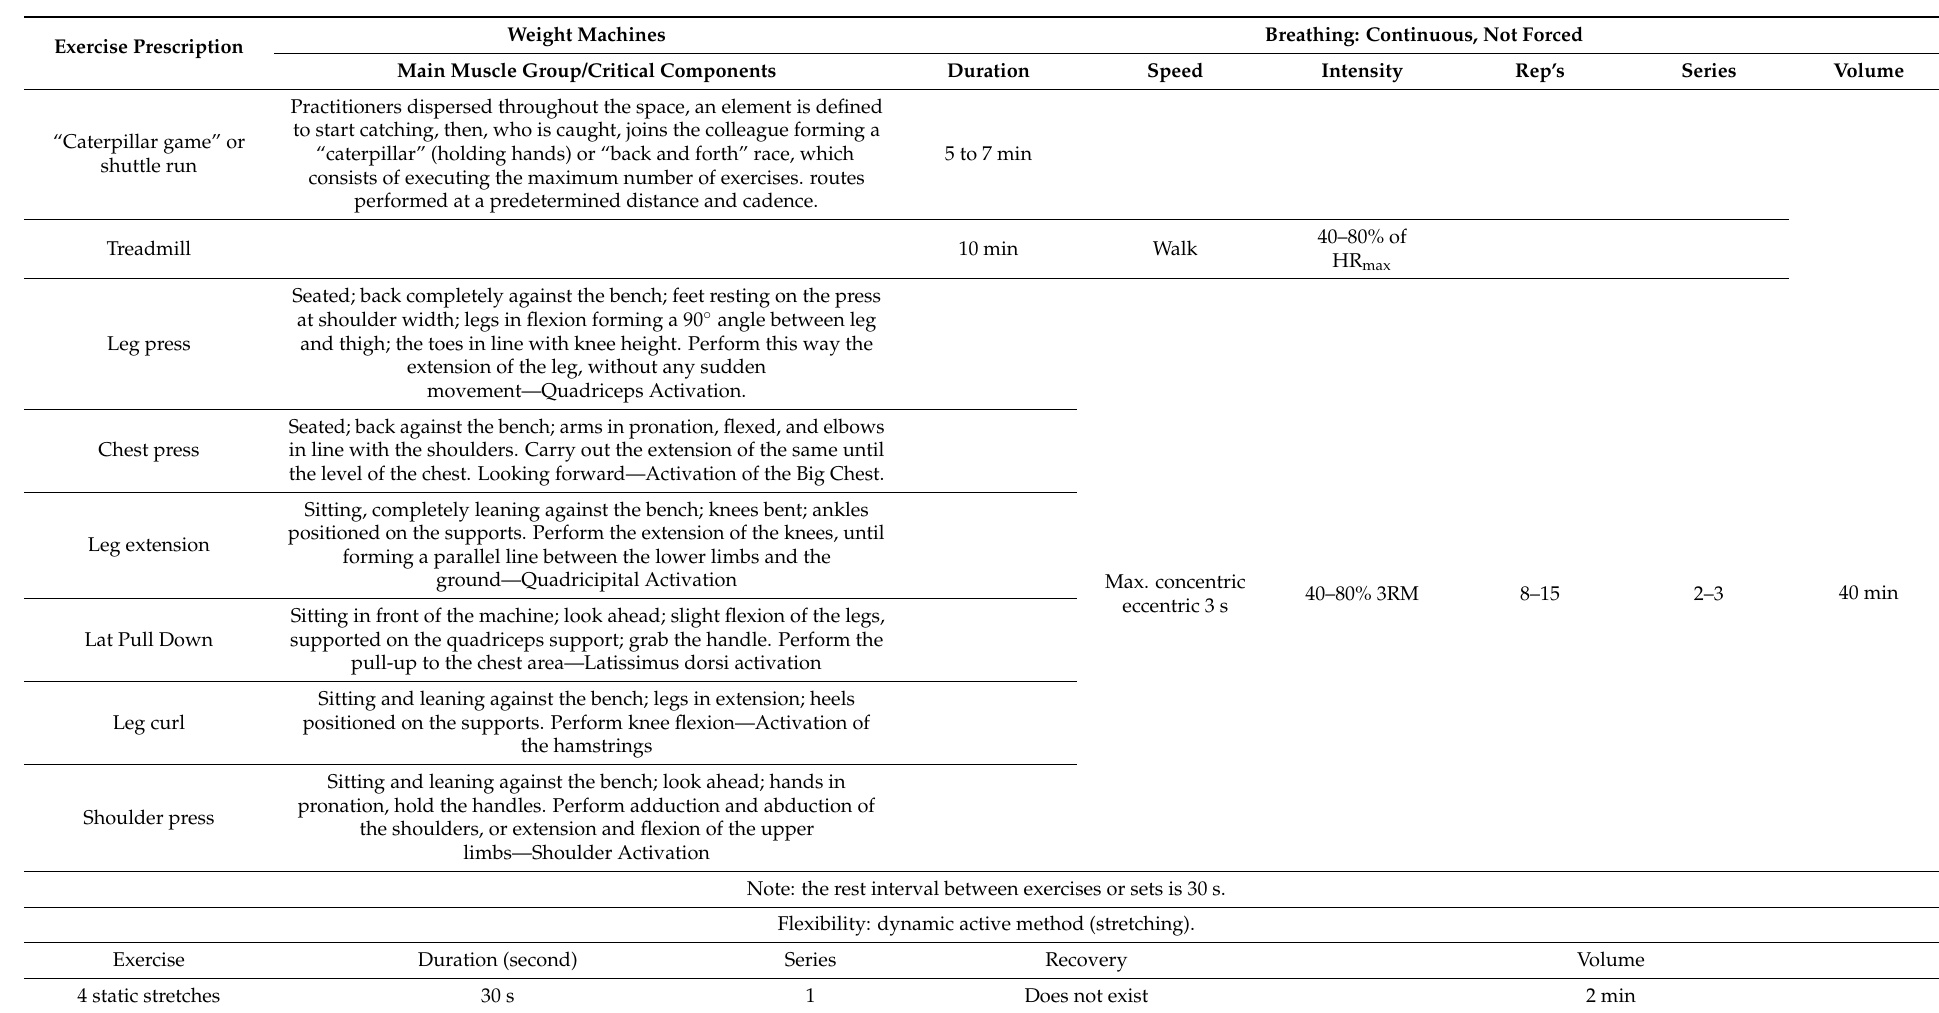
Table 1. Indoor training